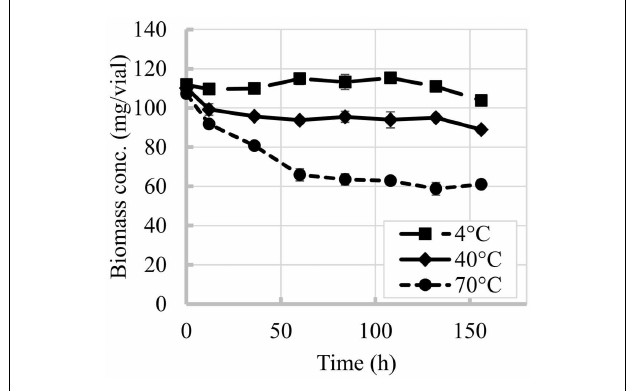
FIGURE 3 |Time evolution of percent FAME content (% total DW) at three different temperatures (repeated experiment) . Error bars represent SD from three independent experiments. SD not visible is overlapped with the